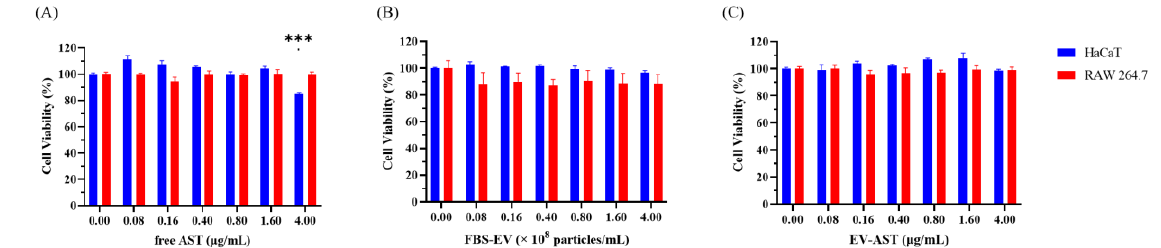
Figure 5. Evaluation of cytotoxicity in HaCaT and RAW 264.7 cells. The viability of HaCaT and Raw 264.7 cells in the presence of ( A ) free AST (0, 0.08, 0.16, 0.4, 0.8, 1.6, and 4 μg/mL), ( B ) FBS-EVs (0, 0.08, 0.16, 0.4, 0.8, 1.6, and 4 × 10 8 particles/mL), and ( C ) EV-ASTs (0, 0.08, 0.16, 0.4, 0.8, 1.6, and 4 μg/mL) (***: p < 0.001).